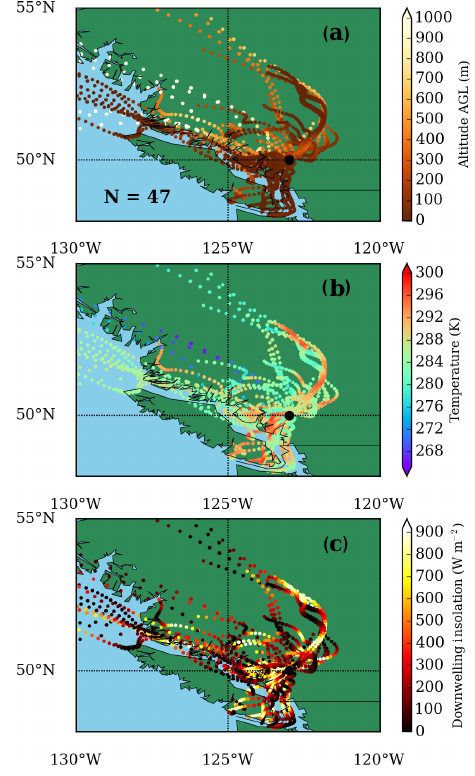
Figure 8. Two-day back trajectories for July 2010 including only times with low biomass-burning or Asian anthropogenic influence (N80 BASE –N80 noAsia < 50cm − 3 and N80 BASE – N80 noBioB < 100cm − 3 ) and N80 BASE > 1000cm − 3 . The trajec- tories are colored by (a) altitude above ground level, (b) surface air temperature, and (c) downwelling insolation. The end point of the trajectory is set to 100m above ground level. The black circle represents Whistler Peak and the number of back trajectories is given by N